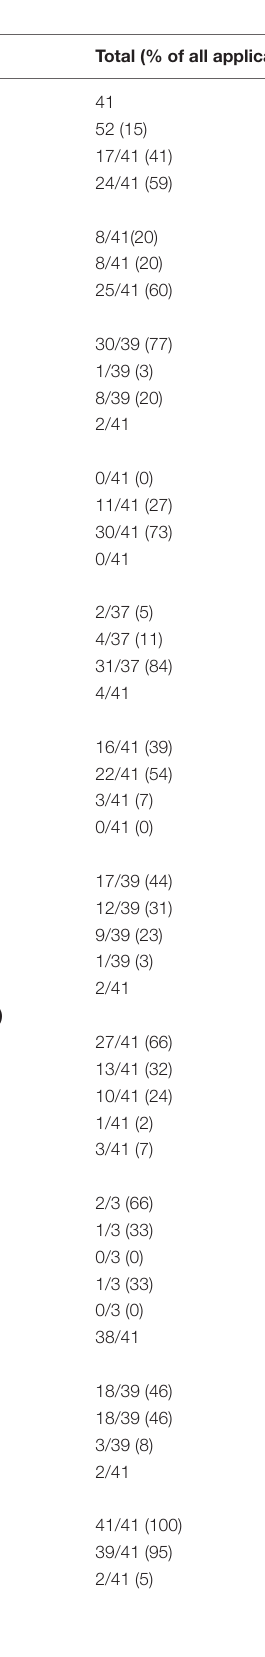
TABLE 1 | Patient